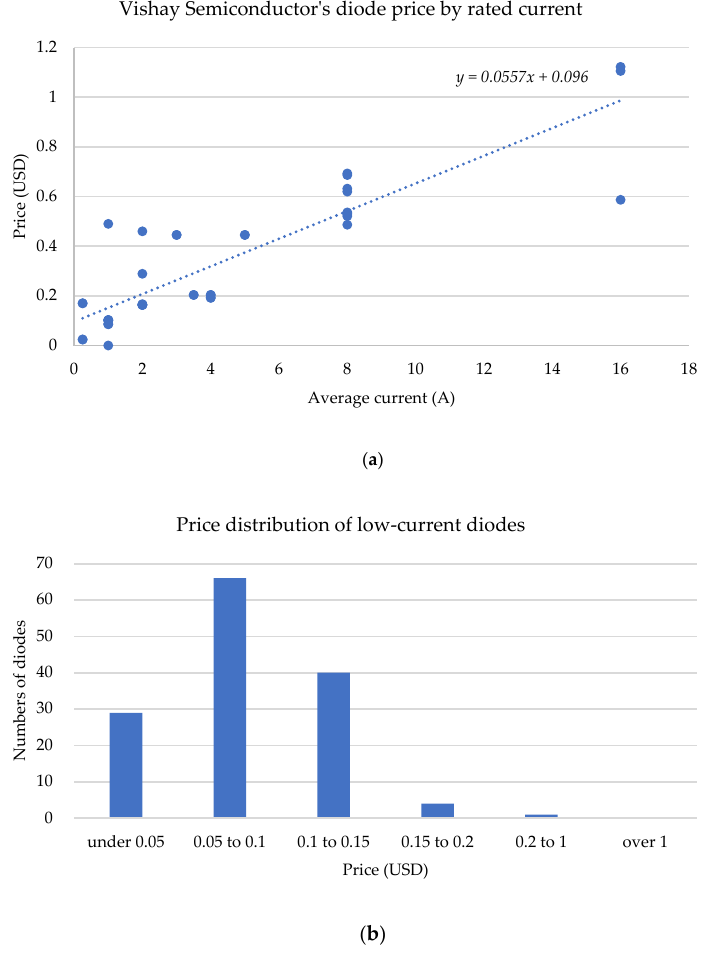
Figure 8. Price distribution of IXYS’s power MOSFET according to the power rating.